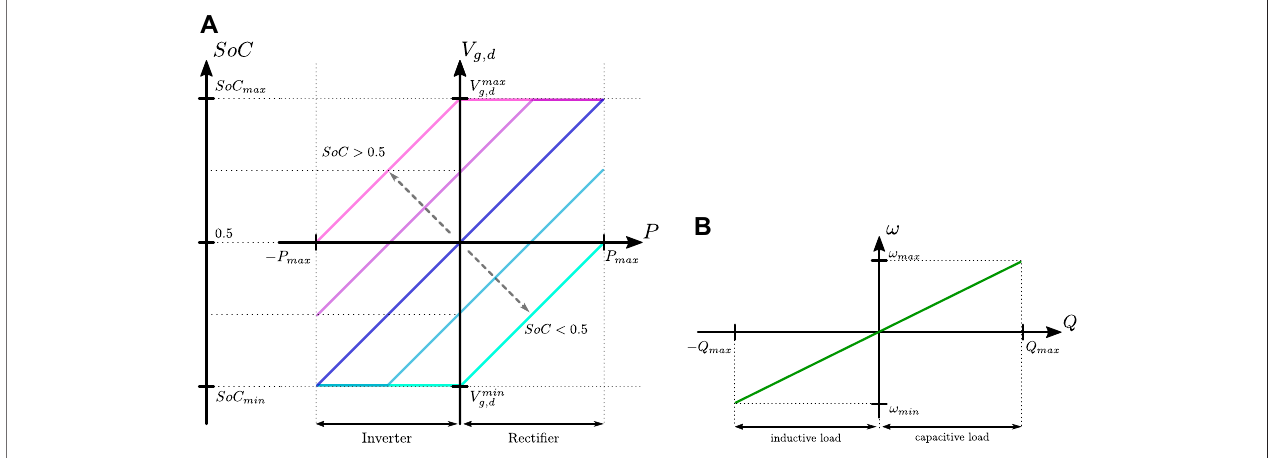
FIGURE 4 | Representation of the grid-forming converter droop curves. (A) is the P / SoC − V droop, (B) the Q − ω droop.